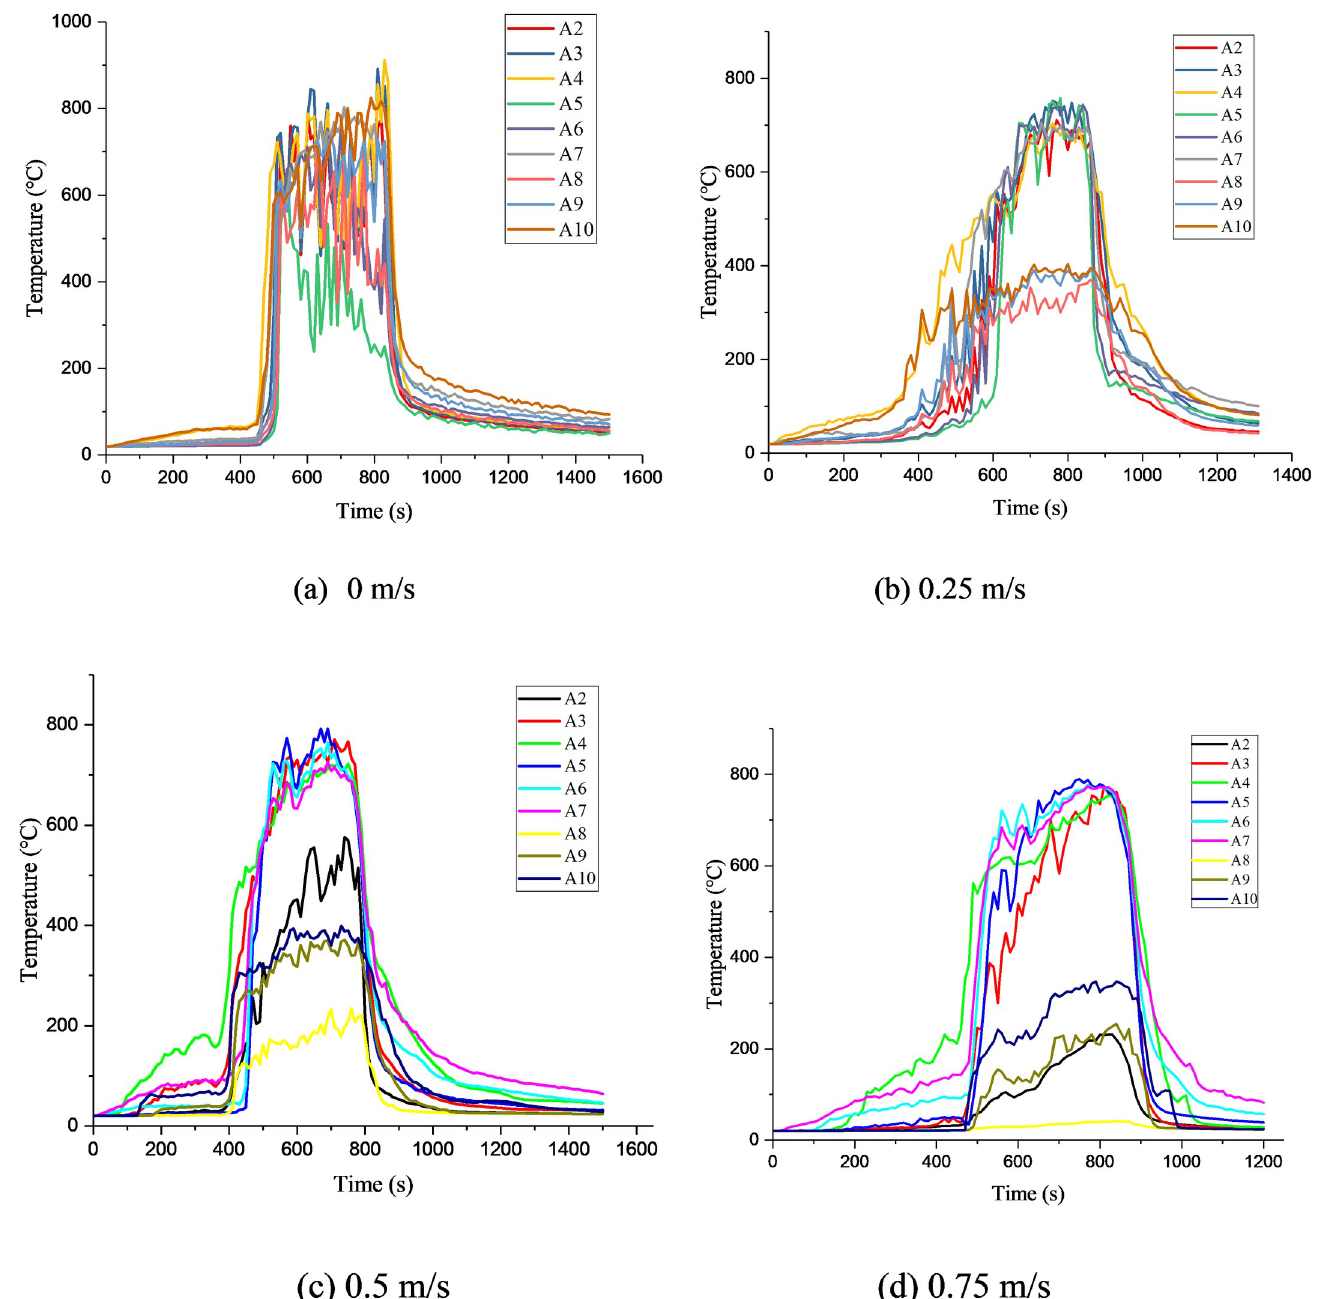
Fig 17. Temperature change in lining fire spreading under different wind